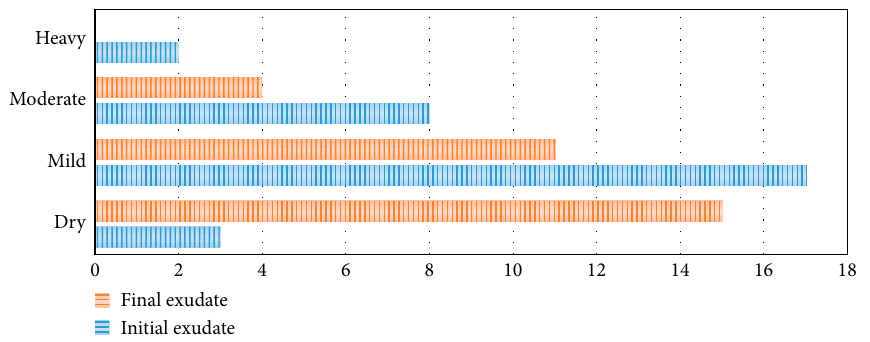
Figure 9: Comparison exudate at start and end of treatment with PolyHeal ® Micro.